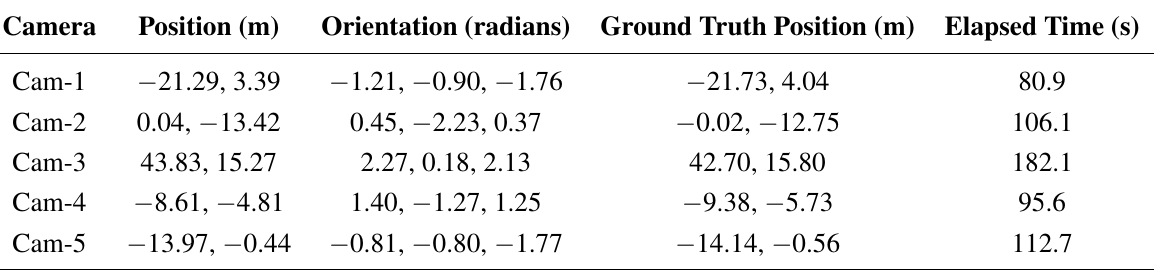
Table 4. Estimated external camera parameters for the FME